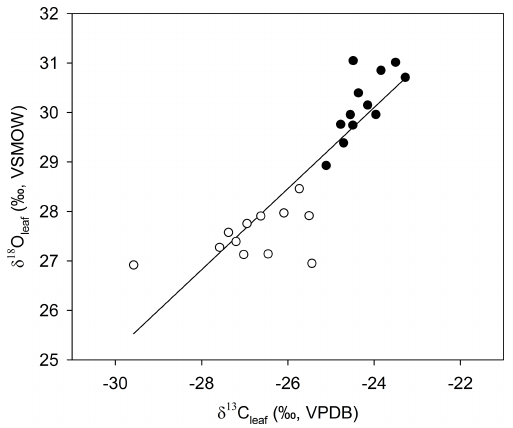
Figure 5. The relationship between average δ 13 C leaf and δ 18 O leaf (Pearson’s correlation coefficient; r = 0 . 877; p < 0 . 001; n = 24). Open circles are average values for samples collected in winter, solid circles represent the average values in